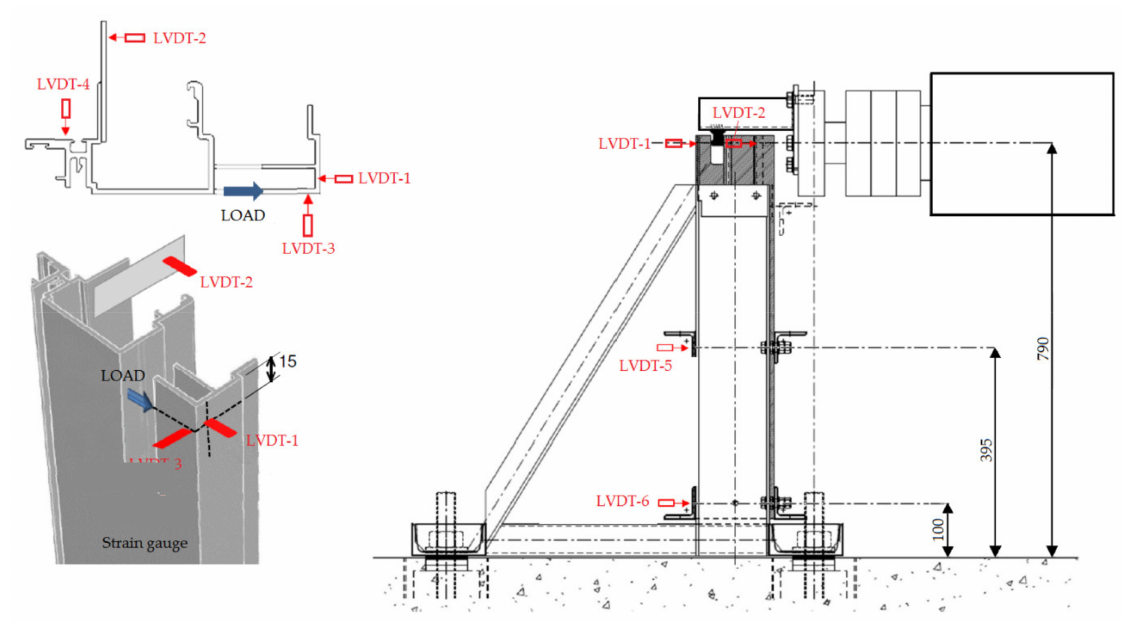
Figure 9. Positions of